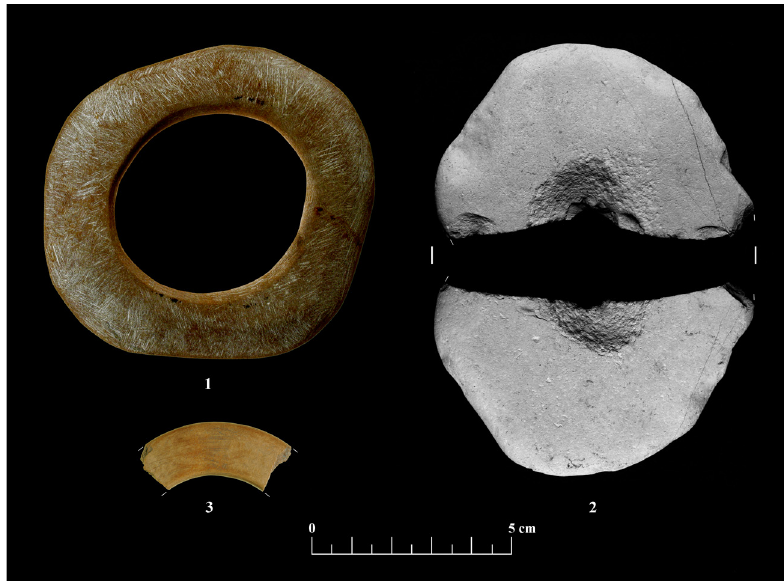
Figure 8: Fiorano settlement at Lugo di Romagna - Fornace Gattelli: ( 1 ) limestone ring bracelet; ( 2 ) fragmented limestone discoid; ( 3 ) fragmentary bone ring bracelet ( after Micheli, 2018 )